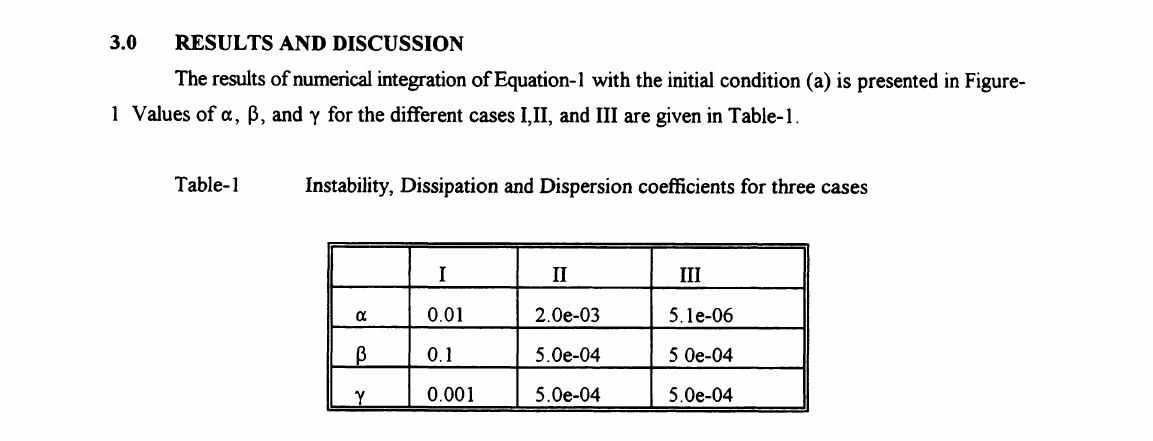
Instability, Dissipation and Dispersion coefficients for three